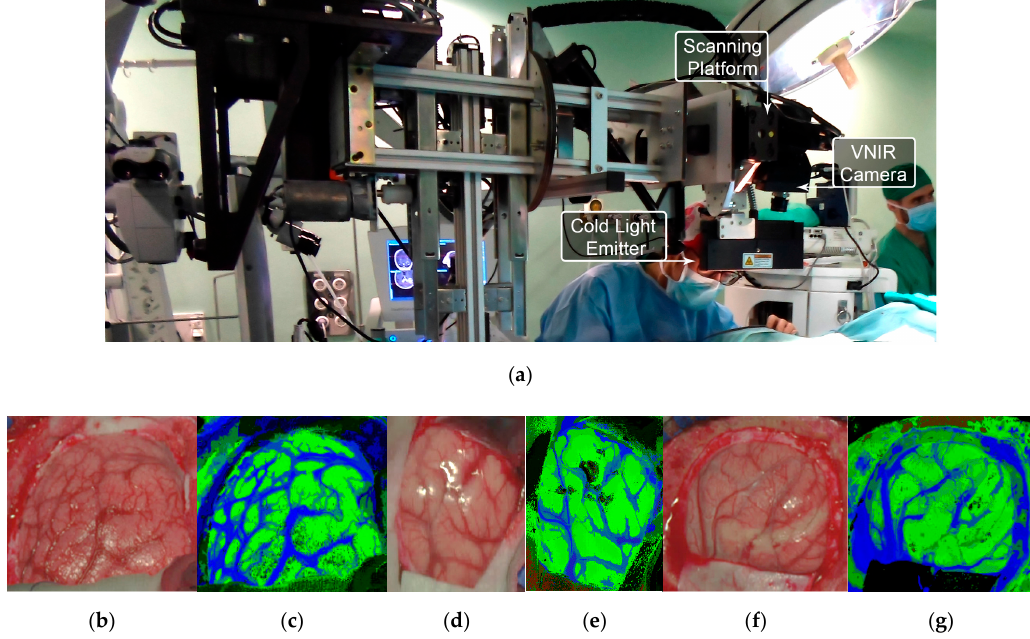
Figure 11. HELICoiD demonstrator [164] and normal brain image results obtained from the validation database employed in [171]. ( a ) HELICoiD demonstrator; ( b , d , f ) Synthetic RGB images; ( c , e , g ) Thematic maps of the HS image, where the normal tissue is represented in green color, the hypervascularized tissue in blue and the background in black. Reproduced from [171]; Creative Commons BY 4.0; published by MDPI (2018).